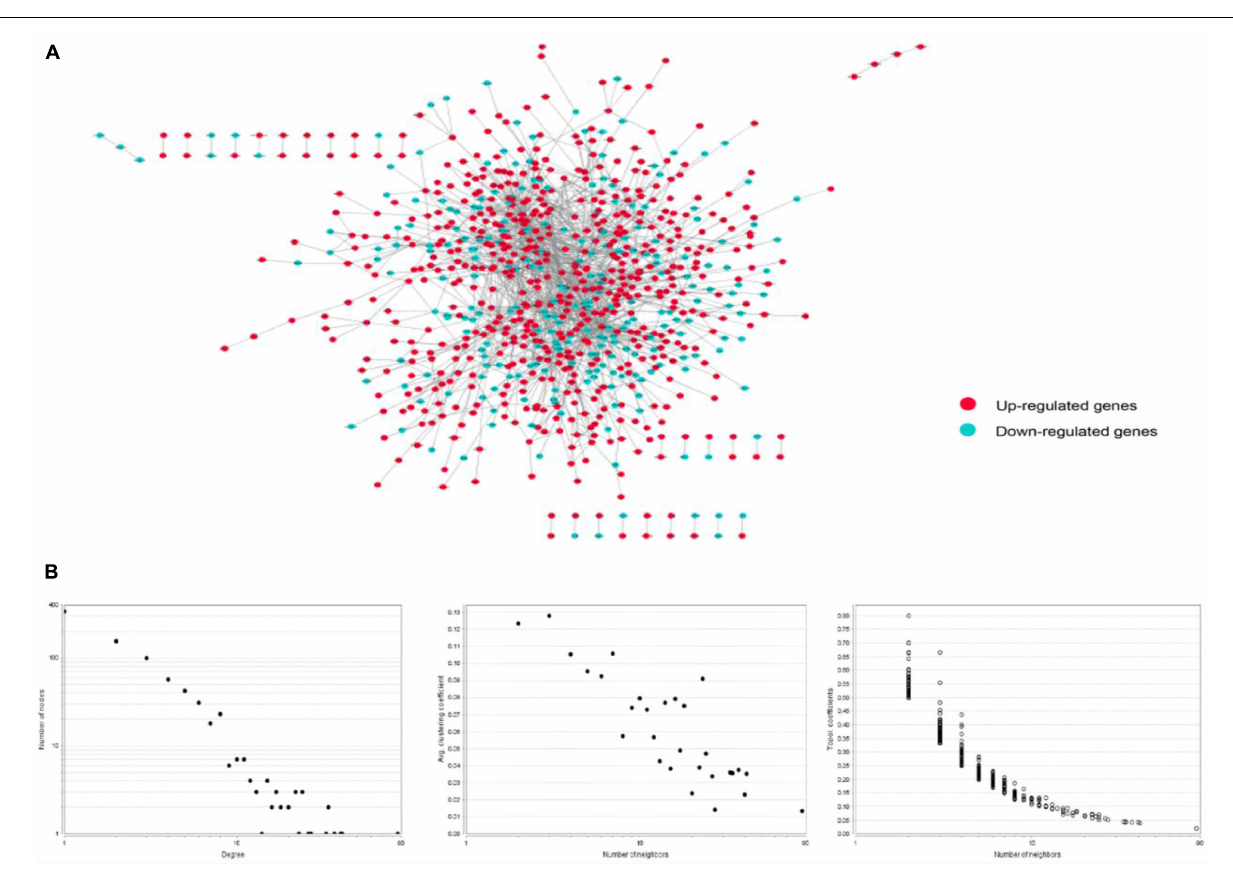
Gene ontology (GO) functional profiles of the significant differentially expressed genes from these two data sets were clustered based on similarity using the “compareCluster_go” function of the “clusterProfiler” R package (Yu et al.,